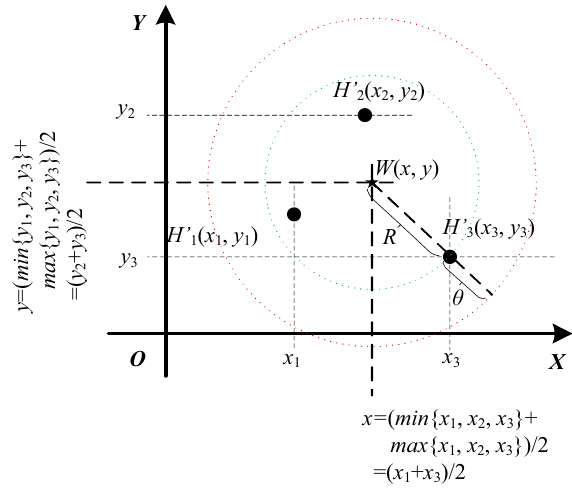
Figure 5. Principle map of physical-layer channel modeling.